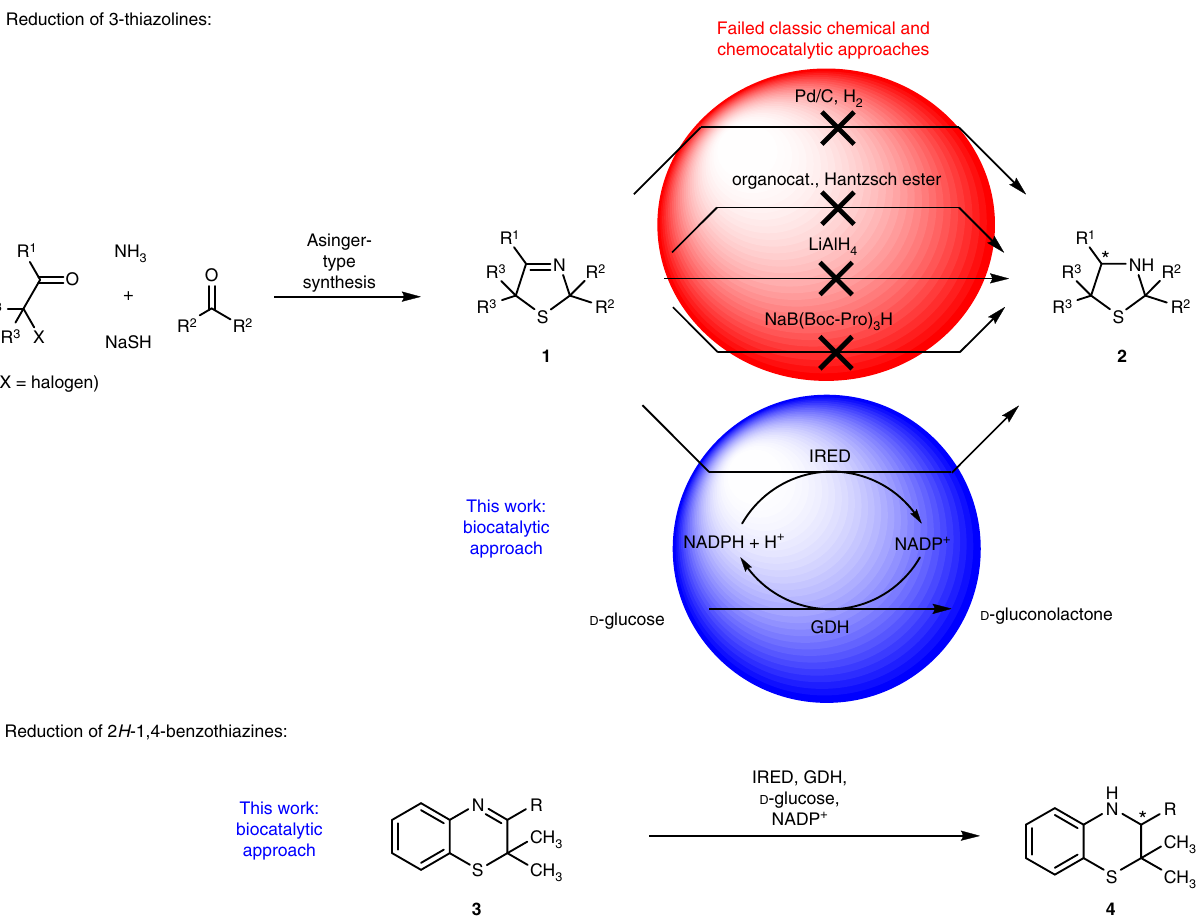
Fig. 2 Concept of this work. a Access toward 3-thiazolines via Asinger-type synthesis and subsequent reduction to 3-thiazolidines. Whereas nearly all classic chemical and chemocatalytic approaches toward reduction of 3-thiazolines failed, reduction with imine reductases provided 3-thiazolidines in high conversion and enantioselectivity. b The biocatalytic approach using imine reductases was also successfully applied for the reduction of other sulfur- containing heterocyclic imines, such as 2 H